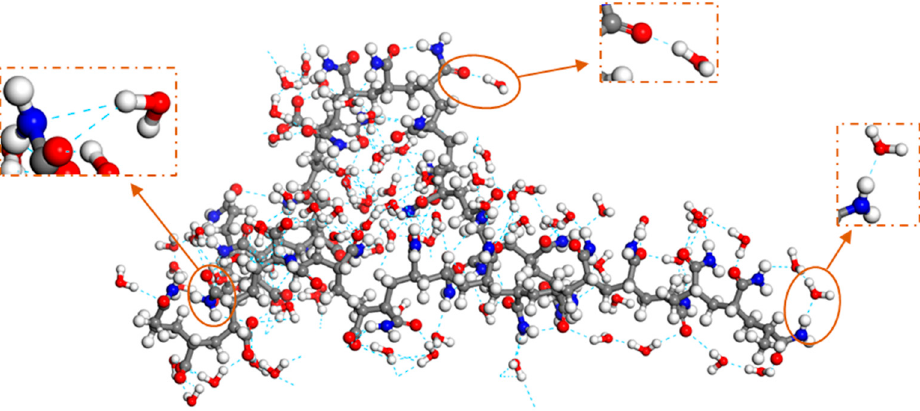
Figure 8. Snapshots of the formation hydrogen bond between HPAM and water molecules.